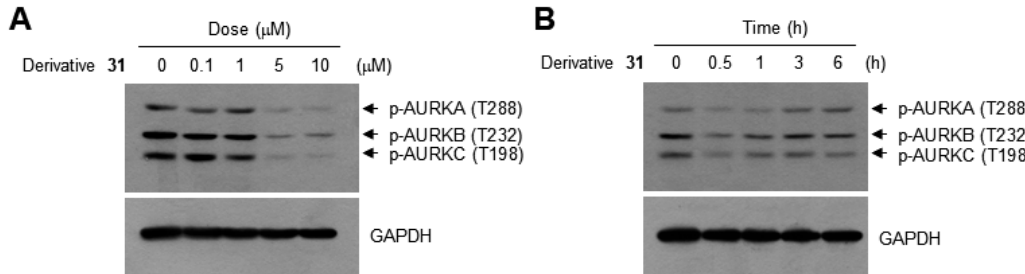
Figure 4. Effect of derivative 31 on inhibition of aurora kinases. HCT116 cells were serum-starved for 24 h in media containing 0.5% FBS, and treated with different concentrations of derivative 31 (0, 0.1, 1, 5 or 10 µ M) for 3 h ( A ) or 5 µ M derivative 31 for different times (1. 0.5, 1, 3 or 6 h) ( B ). Total cell lysates were immunoblotted with phospho-specific antibodies against AURKA (T288), AURKB (T232) and AURKC (T198). Anti-GAPDH antibody was used as an internal control.